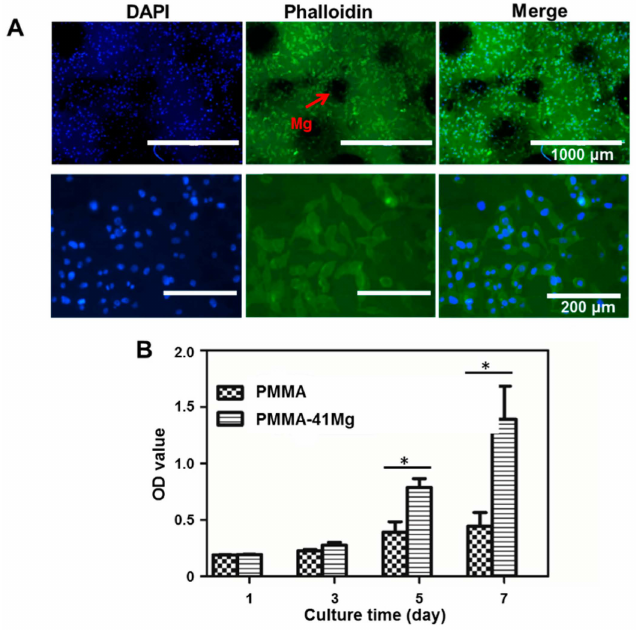
Figure 8. ( A ) Fluorescent staining images of MG-63 cell adhesion on PMMA–41Mg bone cements and ( B ) proliferation of MG-63 cell on PMMA–Mg bone cement. * p <